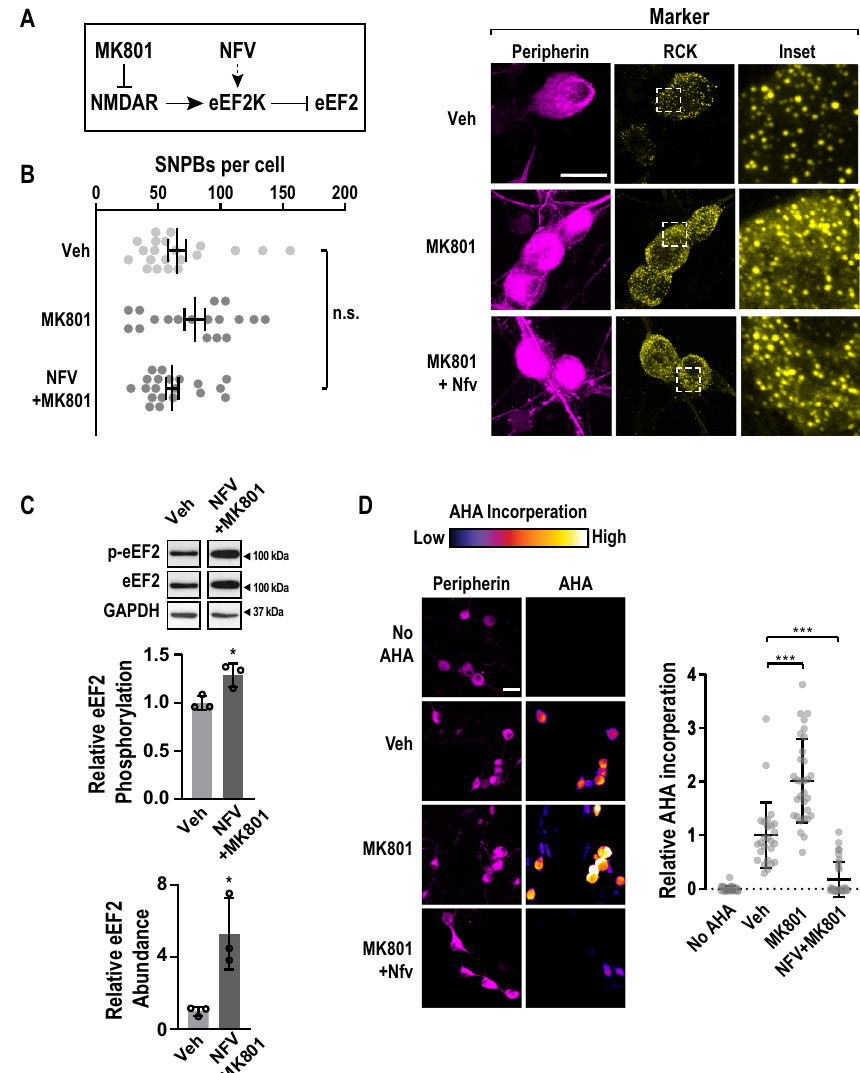
Fig. 4 Inhibition of NMDA receptors counteracts nel fi navir-induced PB loss. A A schematic that indicates the relationship between MK801, an NMDAR antagonist, Nel fi navir (NFV), eEF2K, and eEF2. B left Primary DRG cultures were treated with vehicle (Veh), MK801 (10 µ M), or co-treated with nel fi navir and MK801 (NFV + MK801) for a period of 1 h, and subjected to ICC. Confocal imaging was used to identify p-bodies and key markers. DRG neurons were identi fi ed by peripherin immuno fl uorescence (magenta) and SNPBs were identi fi ed based on Rck (yellow). Nuclei were stained with DAPI (cyan). B left Representative confocal images. Scale bar = 20 µ m. B right Quanti fi cation of PBs per peripherin-positive cell. For Veh, MK801, and MK801 + NFV, n = 21, 18, and 20 cells, respectively. Bars indicate mean ± SEM. P -values determined by one-way ANOVA. C Primary DRG cultures were treated with vehicle (Veh) or co-treated with nel fi navir and MK801 (NFV + MK801). Lysates from treated cells were probed for p-eEF2, eEF2, and GAPDH (load control). C upper Representative immunoblots (cropped to depict one representative band per condition). C middle Quanti fi cation of mean p-eEF2/eEF2 signal. C lower Quanti fi cation of mean eEF2 normalized to GAPDH, n = 3 biological replicates. Error bars represent ±SD. P -values determined by Unpaired two-tailed t test. Upper panel p = 0.329, lower panel p = 0.0204. D Primary DRG cultures were subjected wo the same treatments as in B with the addition of a 30- min pulse of AHA. Cultures were then used for FUNCAT as well as peripherin immune-labeling before confocal imaging. As a control, a no-AHA group was also imaged. D left Representative confocal images. Scale bar = 30 µ m. D right Quanti fi cation of AHA incorporation in peripherin positive cells. For No AHA, Veh, MK801, and MK801 + NFV, n = 29, 26, 31, and 31 cells, respectively. Bars indicate mean ±SD. P -values determined by one-way ANOVA.